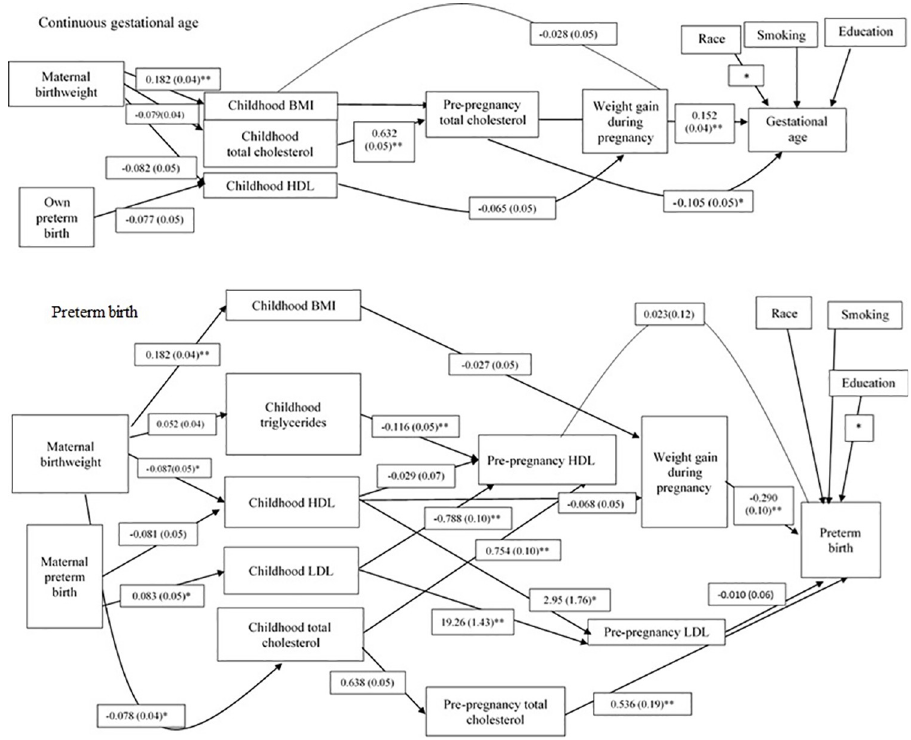
Fig 2. Path model for gestational age. Top panel, continuous gestational age; bottom panel, preterm birth. BMI, body mass index; HDL, high-density lipoprotein.